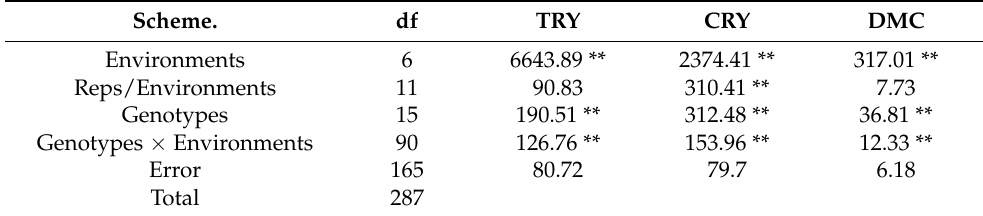
Figure 2. Sprouting and plant height of selected genotypes evaluated under several environmental conditions. ( a ) Plant height in evaluated genotypes, ( b ) plant height in genotypes evaluated in seven environments. Different letters show significant differences obtained by Tukey’s test ( p < 0.05). Table 3. Mean squares for total root yield (TRY), commercial root yield (CRY), and dry matter content